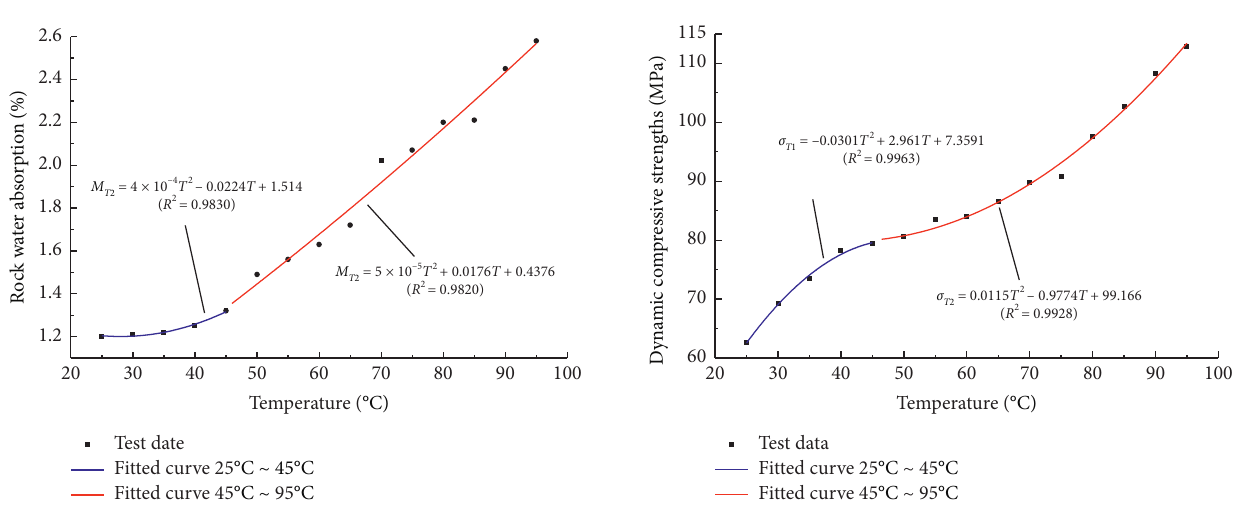
Figure 5: Relationship between water absorption of sandstone and water bath temperature.